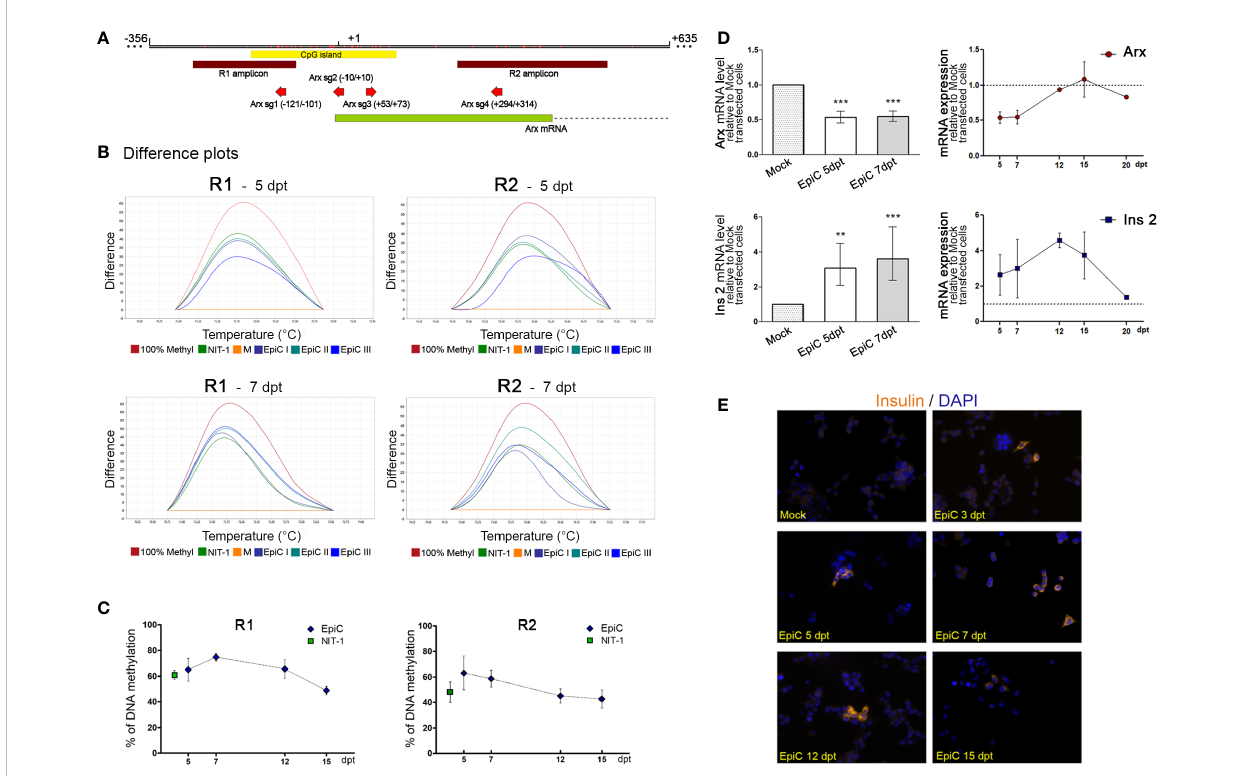
FIGURE 5 The induced targeted DNA methylation of the Arx promotor triggers Ins2 expression in a TC1-6 cells. (A) Schematic representation of a part of the Arx gene with the position of primers used for DNA methylation analysis (R1 and R2 amplicons); the CpG island; and four sgRNAs shown in the inset. Mock-transfected cells with 5% pmaxGFP, 20% dCas9-Dnmt3a3L-KRAB, 75% empty gRNA; EpiC-transfected cells with 5% pmaxGFP, 20% dCas9- Dnmt3a3L-KRAB, 75% all four sgRNAs. (B) Representative difference plots obtained from HRM analysis in two different regions of the Arx gene